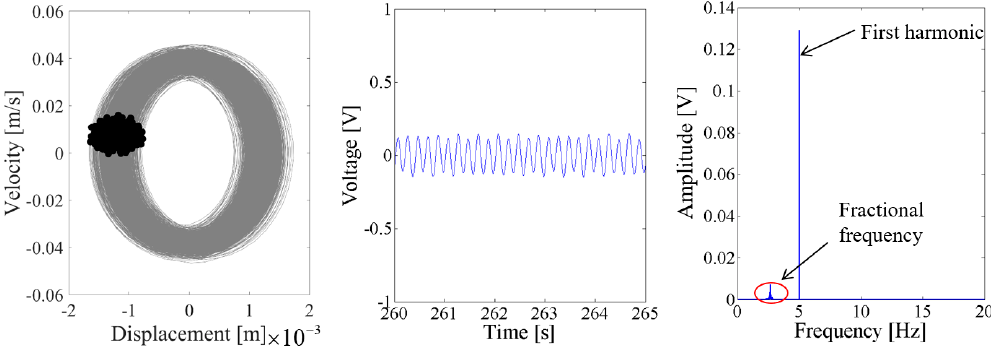
Figure 14. Dynamic responses of the coupled harvester-1 for the excitation level of 0.1 g.